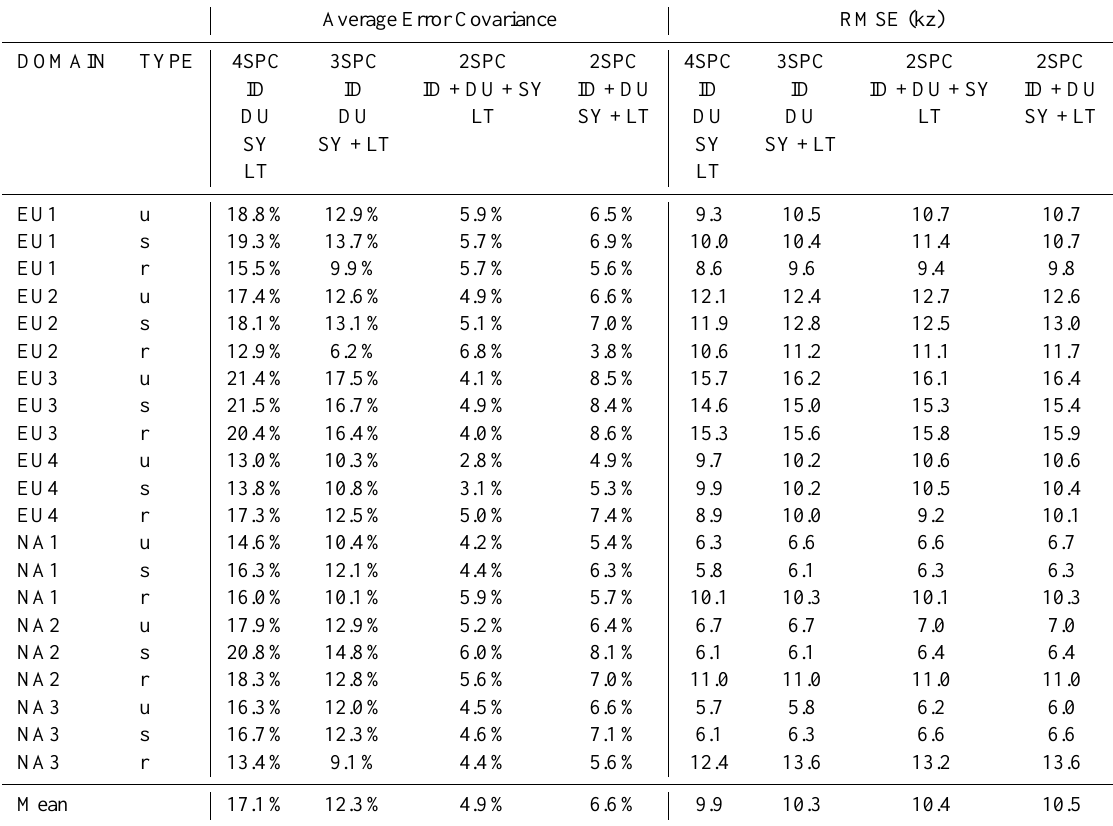
Table 7. Independence of spectral components versus error. The covariance of the error is averaged over all models. Using only two spectral components, being either (ID+DU+SY, LT) or (ID+DU, SY+LT), the decomposition achieves independent factors, but their corresponding kz model has ∼ 5% higher RMSE (compared to the case of four spectral